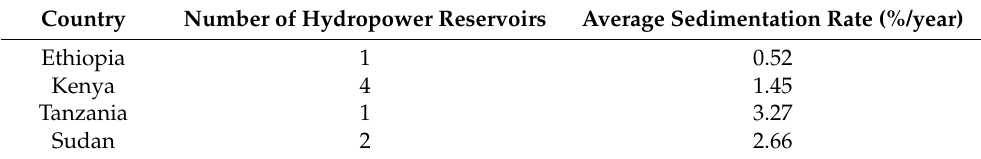
Table 2. Sedimentation rate of East African hydropower reservoirs